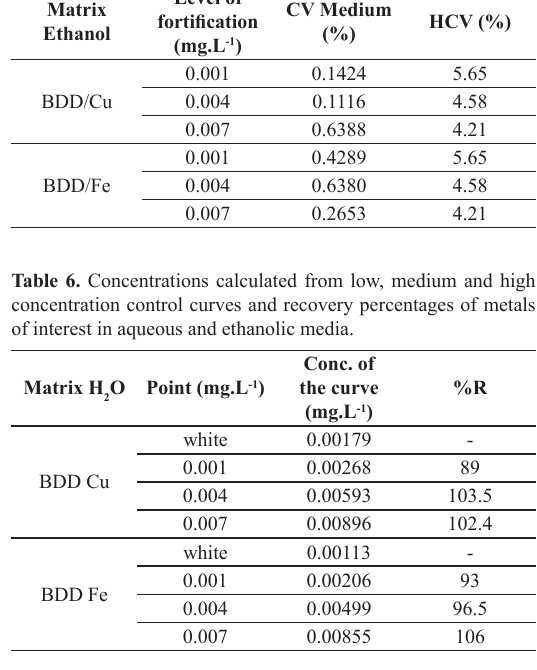
Table 7. Concentrations calculated from low, medium and high concentration control curves and recovery percentages of metals of interest in aqueous and ethanolic media.